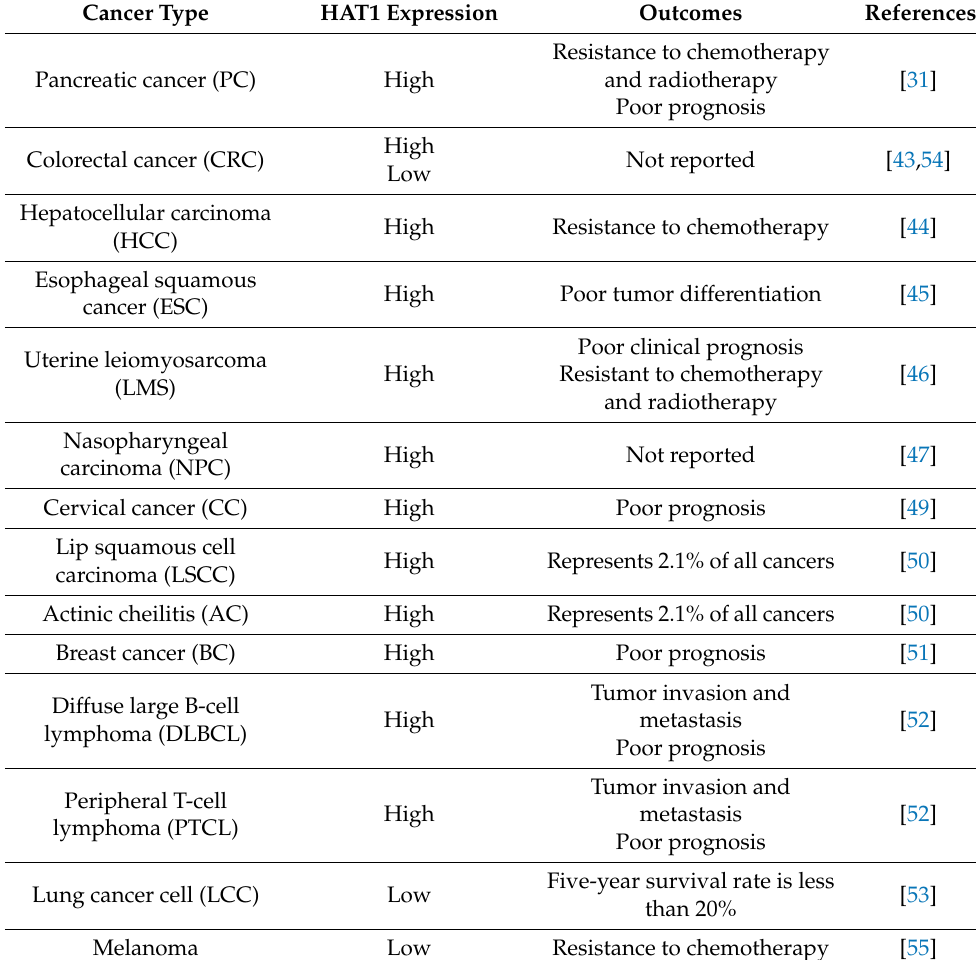
Table 1. Overview of HAT1 expression and related outcomes in different cancer